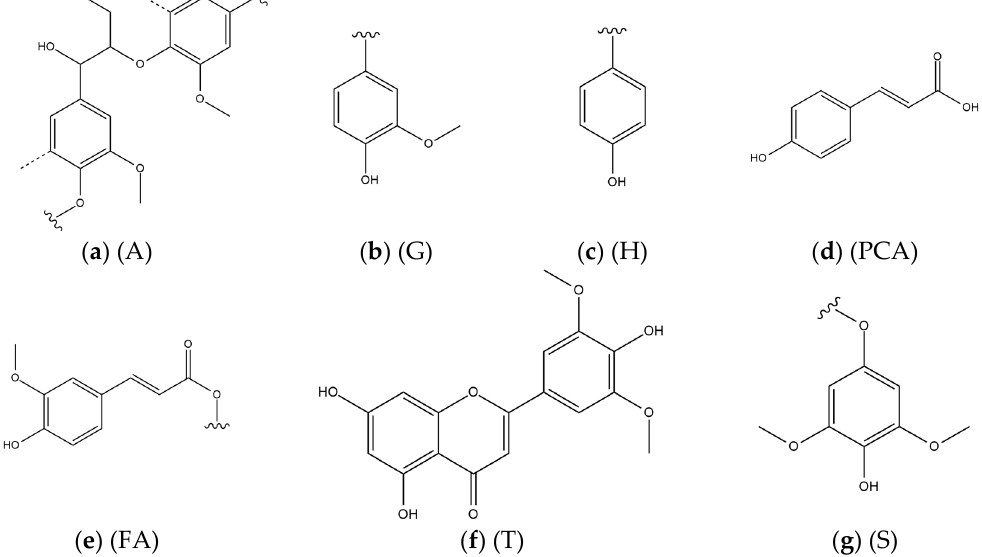
Figure 7. Main structures identified using 2D NMR: (A) β -O-4 ′ alkyl-aryl ethers with acylated γ -OH; (G) guaiacyl unit; (H) p-hydroxyphenyl unit; (PCA) p-coumarates; (FA) ferulates; (T) tricin; (S) syringyl unit.